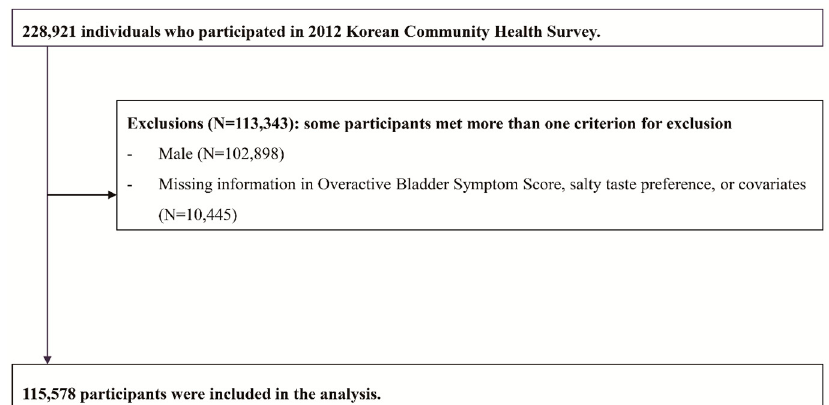
Figure 1. Inclusion and exclusion in the study population.